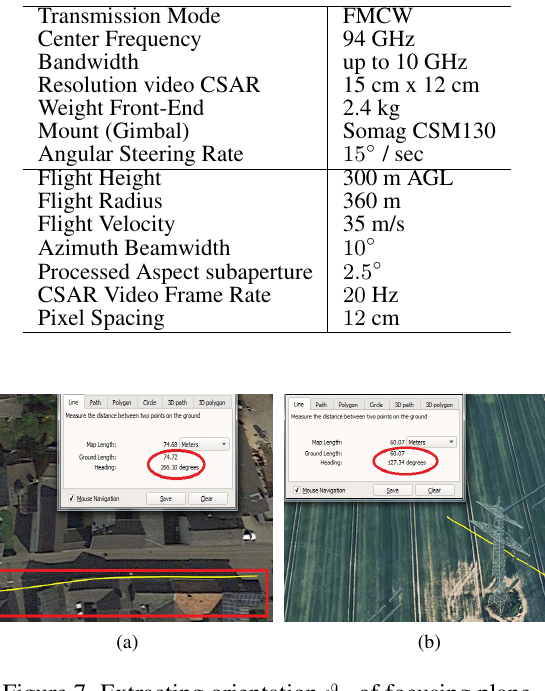
Figure 7. Extracting orientation ϑ f of focusing plane from Google Earth. (a) Carborne facade mapping (b) Airborne infrastructure